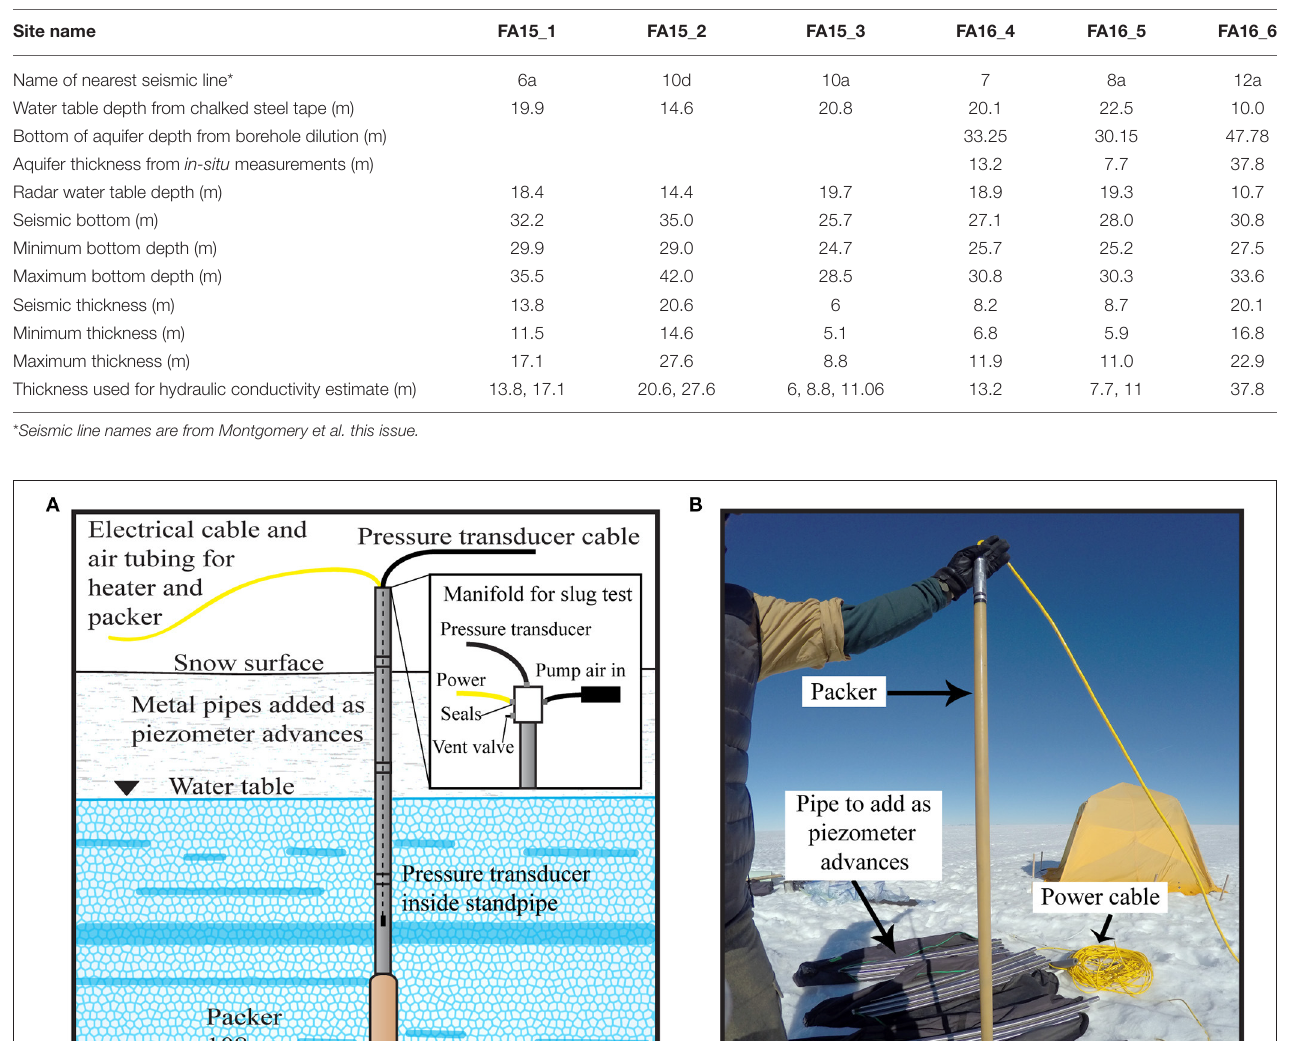
TABLE 2 | Depth to water table and aquifer bottom, and aquifer thickness measurements from in-situ and geophysical